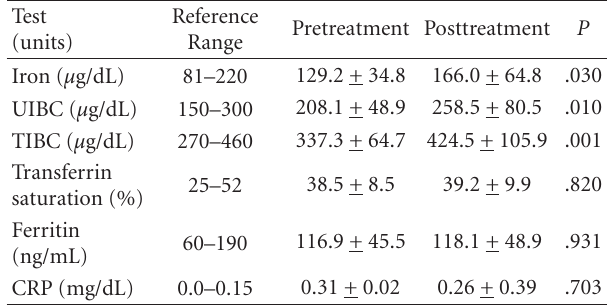
Table 1: Erythrocyte and platelet modifications pre- and posttreat- ment.